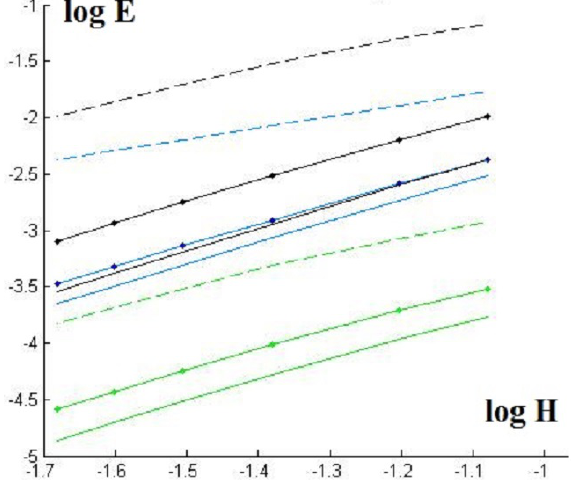
Figure 6. Logarithm of the relative error (log E ) via logarithm of the grid step (log H ); 2-D case, exponentially varying viscos- ity, high-viscosity contrast ( η 2 = η 3 = 100); blue lines – pressure, green lines – v x , black lines – v y ; solid lines – L 1 -error, dashed lines – L ∞ -error, solid dotted lines – L 2 -error.